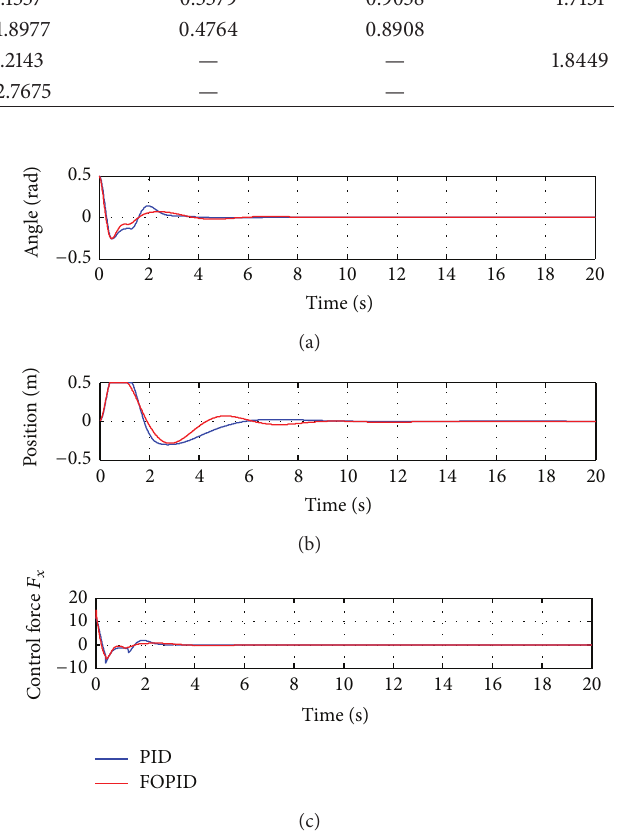
Figure 6: Stabilization of inverted pendulum (without disturbances = 𝑑 = 0 𝑑 1 2